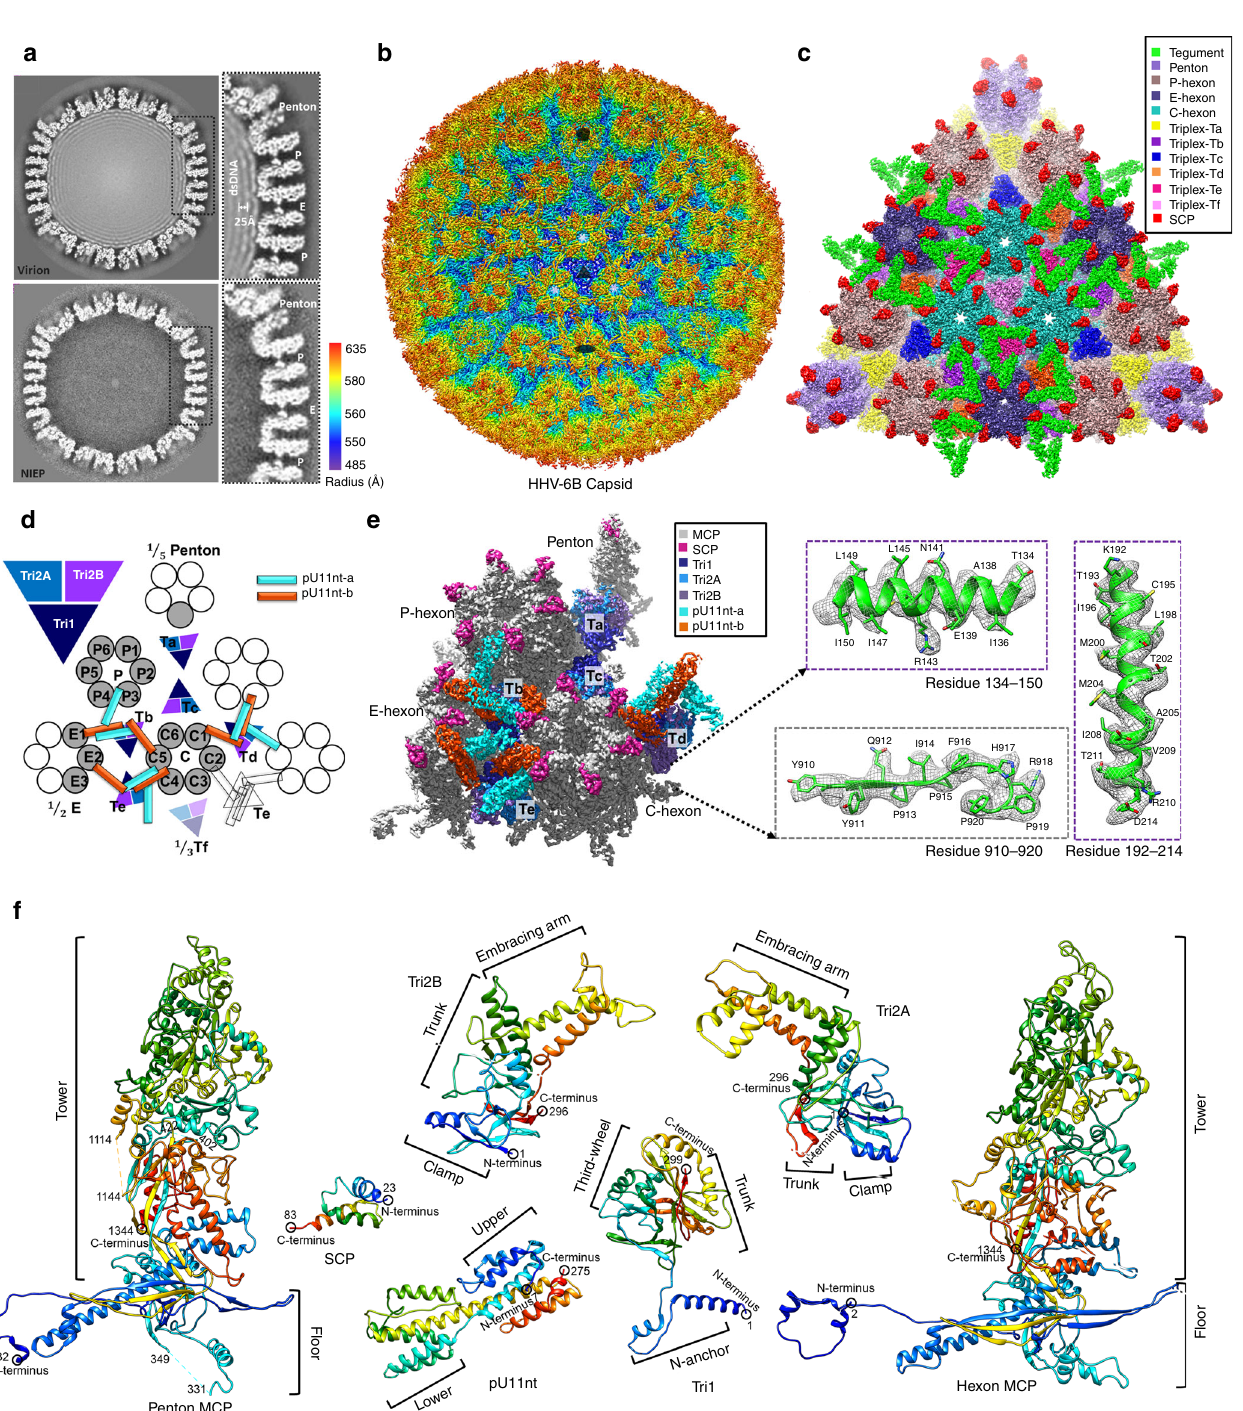
four capsid proteins and one capsid-associated tegument protein (see examples in Fig. 1f), including 15 hexon MCPs, 1 penton MCP, 15 hexon SCPs, 1 penton SCP, 5 copies of the triplex monomer protein (Tri1), 10 copies of the triplex dimer protein (Tri2), and 12 copies of the pU11nt. In total, all 59 proteins amounted to over 29,000 amino-acid residues. Atomic structures of penton and hexon capsomers . The 12 penton and 150 hexon capsomers are each composed of fi ve and six pairs of MCP and SCP, respectively. The structure of the